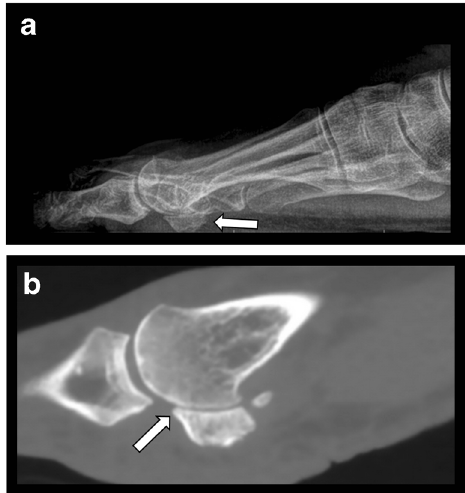
Fig. 8 Sesamoid degenerative changes. a . CR lateral view of the foot in standing position with suspected degenerative changes between the sesamoids and the first metatarsal head. b . CBCT sagittal reformatted image shows osteophyte formation, narrowing of the joint space and subchondral sclerosis at the joint between the plantar aspect of the metatarsal head and the medial sesamoid (arrow)